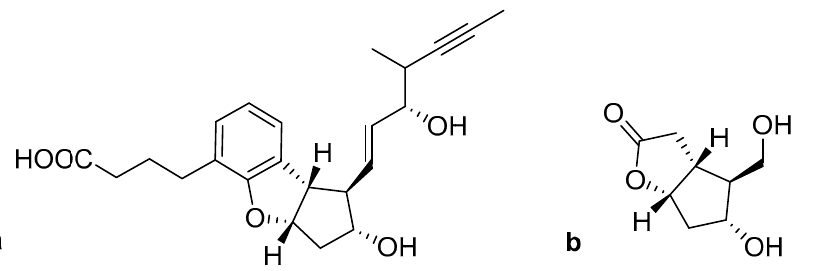
Figure 4. Structures of Beraprost ( a ) and (-)-Corey lactone diol ( b ). RCM proceeded efficiently in the presence of a second-generation Grubbs catalyst under mild conditions and was followed by dehydration step performed in the presence of pyridine hydrochloride (Scheme 36).